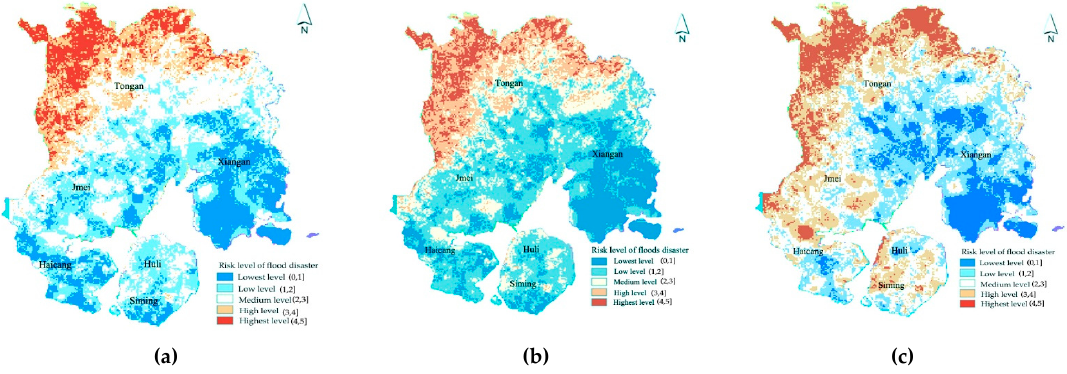
Figure 7. Risk assessment of flood disasters under different scenarios in Xiamen: ( a ) assessment results under the average annual precipitation scenario; ( b ) assessment results under the average precipitation during the flood season scenario; and ( c ) assessment results under the precipitation during typhoon scenario.